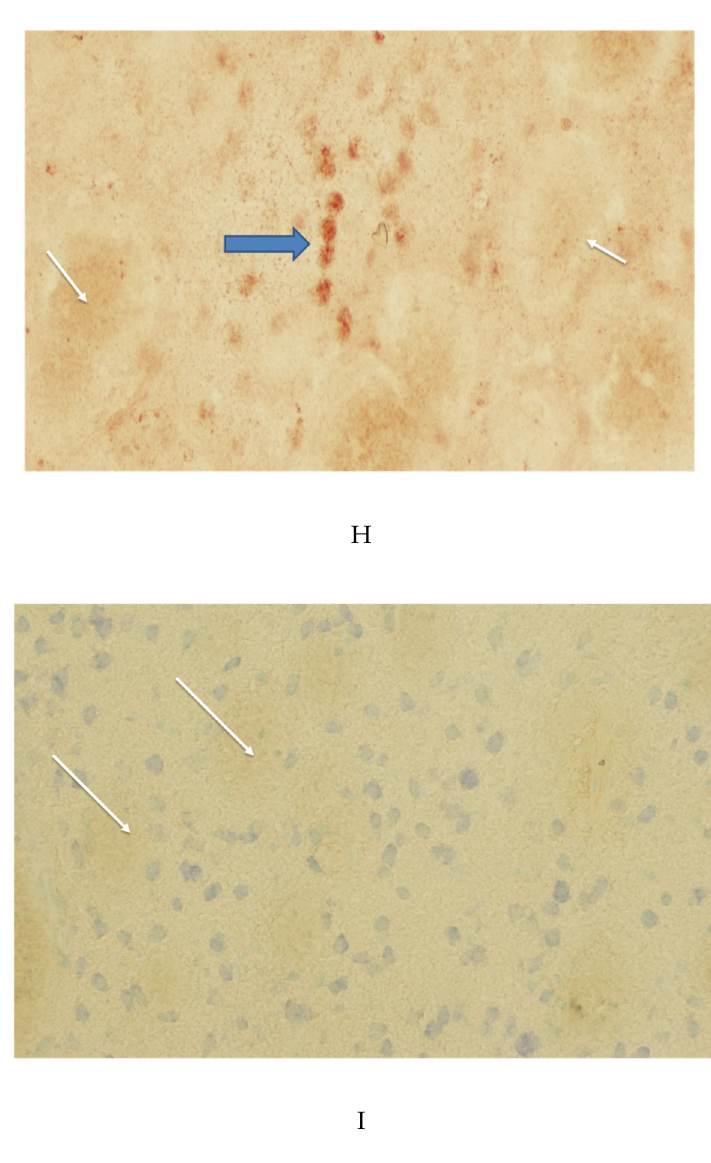
Figure 3. ( A ) HIV-1TGR coronal section of the caudate/putamen stained with hematoxylin and eosin. This image of the 10-micron thick section was taken at 4×. The blue arrows are pointing to gray matter areas. The white arrows are pointing at the fibers of passage. ( B ) HIV-1TGR coronal section of the caudate/putamen stained with CSS. This image of the 75-micron thick section was taken at 10×. The blue arrows are pointing to degenerating neurons. The white arrows are pointing at the fibers of passage. The black arrow points to a gray matter area. The red arrow points to an infiltrated capillary. See Figure 3C for a higher-powered image of the cell at Arrow 2. ( C ) HIV-1TGR coronal section of the caudate/putamen stained with CSS. This image of the 75-micron thick section was taken at an original magnification of 20×. The blue arrow (Arrow 2) is pointing to the degenerating neuron from Figure 3B. The white arrows are pointing at the fibers of passage. The red arrows point to a gray matter area. The black arrows are pointing to silver precipitate. ( D ) HIV-1TGR coronal section of the caudate/putamen stained with CSS. This image of the 75-micron thick section was taken at 20×. The blue arrows are pointing to the degenerating neuron. The white arrows are pointing at the fibers of passage. The red arrows point to a gray matter area. ( E ) HIV-1TGR coronal section of the caudate/putamen stained with CSS and counterstained with neutral red. This image of the 75-micron thick section was taken at 60×. The blue arrows are pointing to the degenerating neuron. The neuron is of a small or moderate type. In addition, it is possible to identify the degenerating fibers. Large arrows point to the degenerating neurosomata, while small arrows point to degenerating fibers. ( F ) A coronal section of the caudate/putamen from the nontransgenic control rat stained with CSS. It was